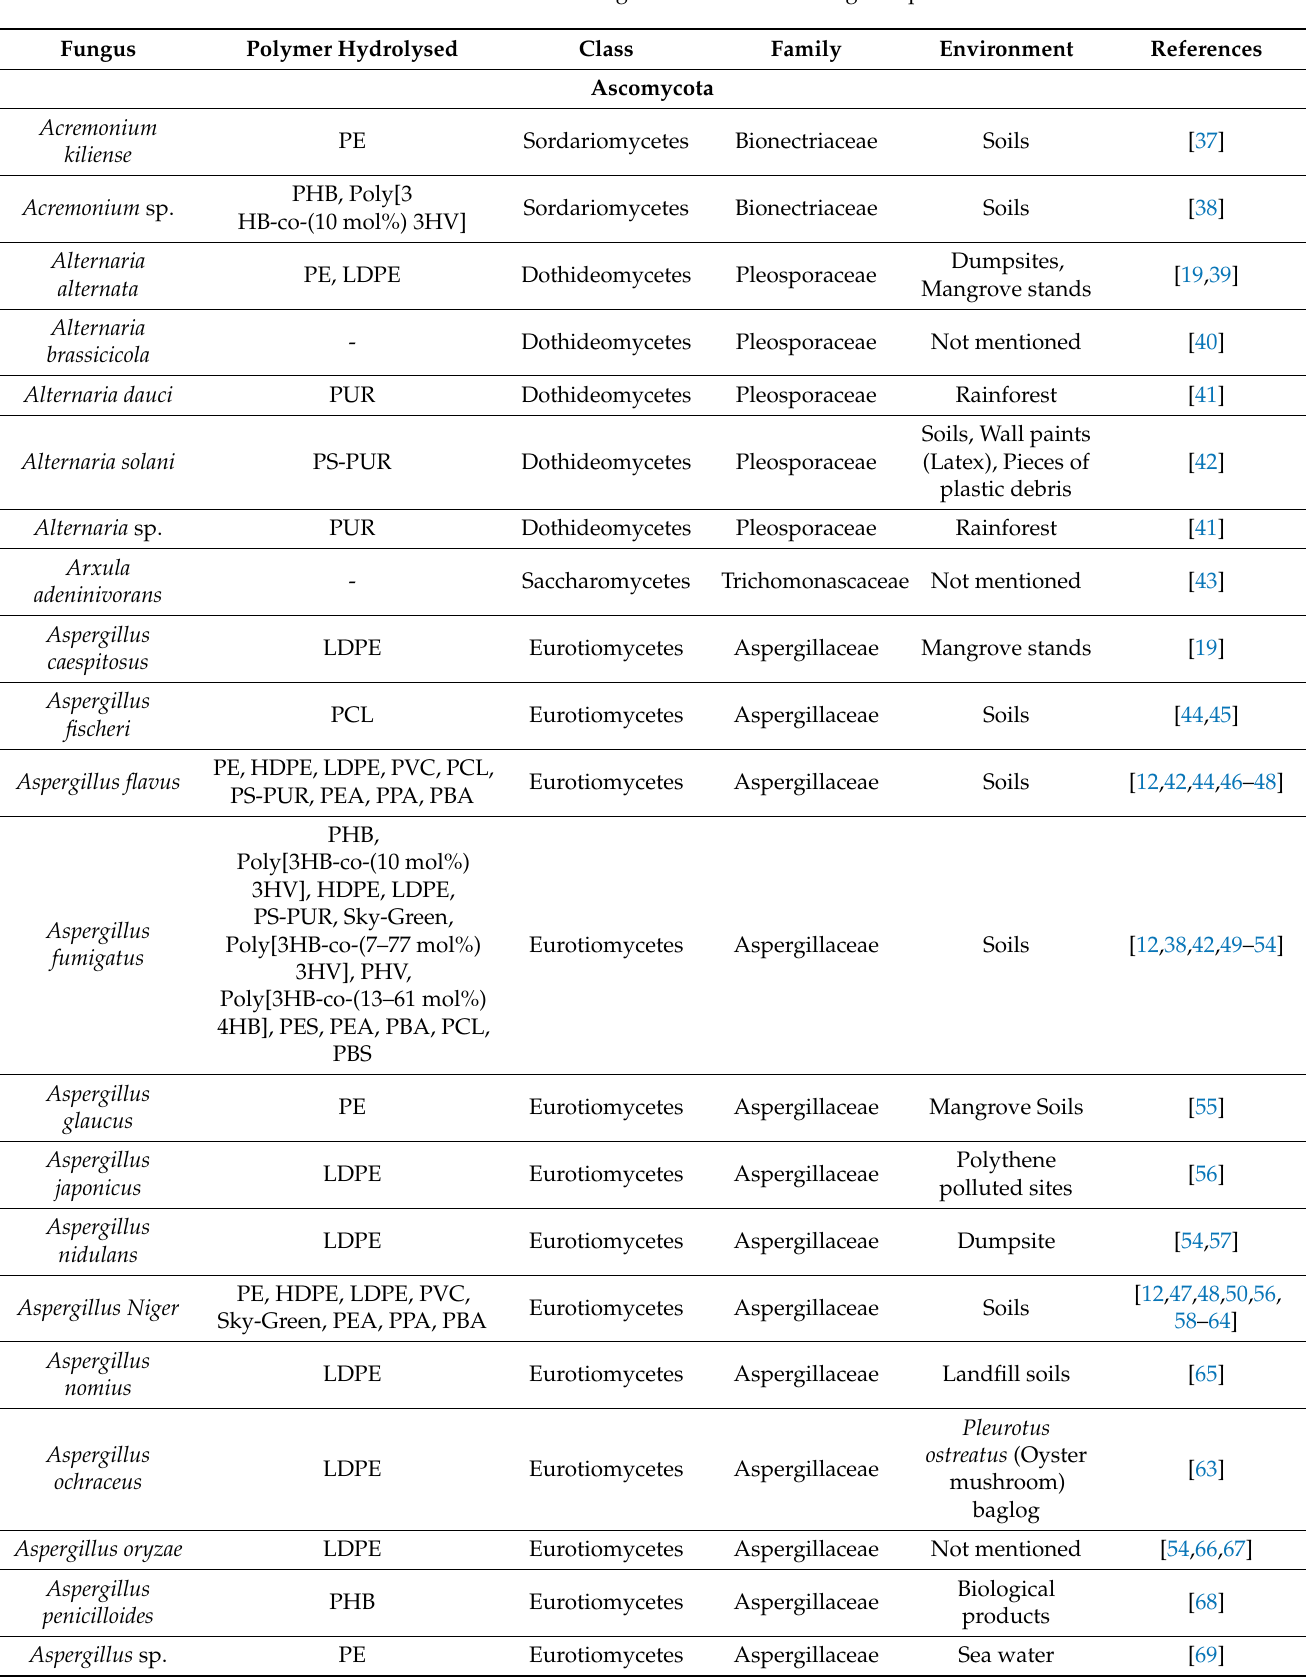
Table 2. Recorded taxa of fungi that are known to degrade